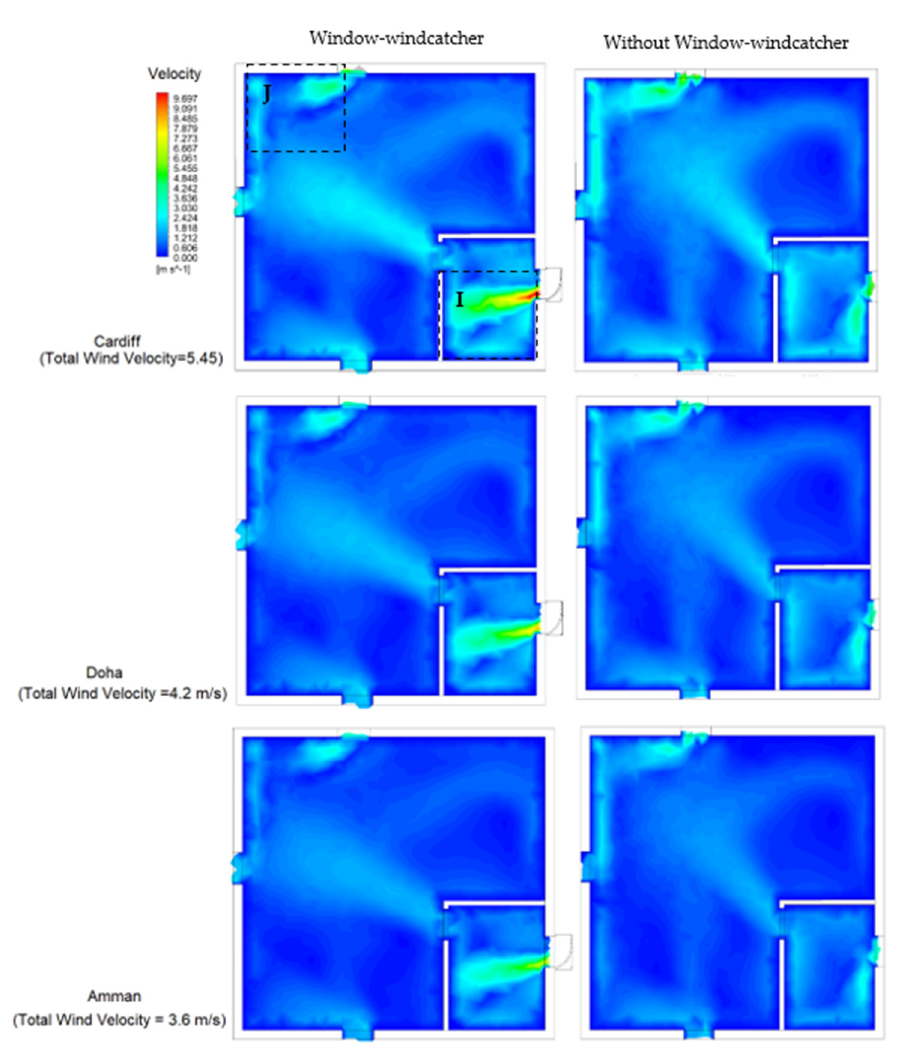
Figure 12. Velocity profile at the 1.7 m interior plane (I and J: High-velocity regions).